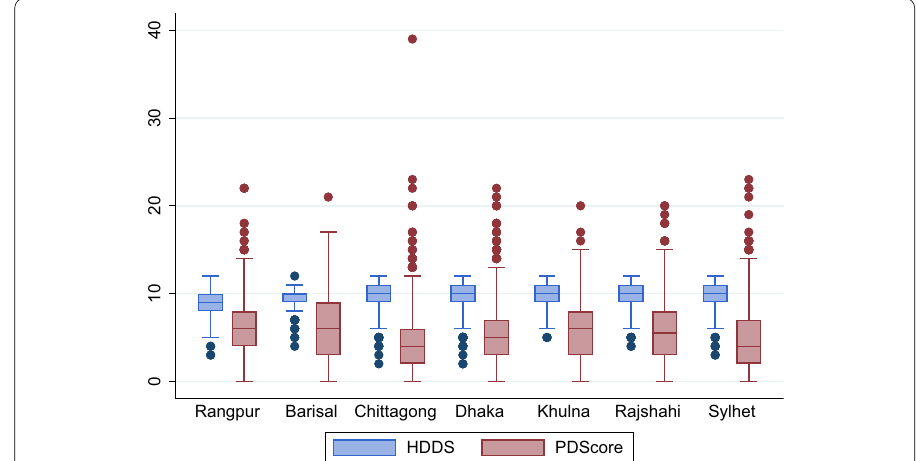
Fig. 3 Division wise household dietary diversity score and production diversity score in Bangladesh